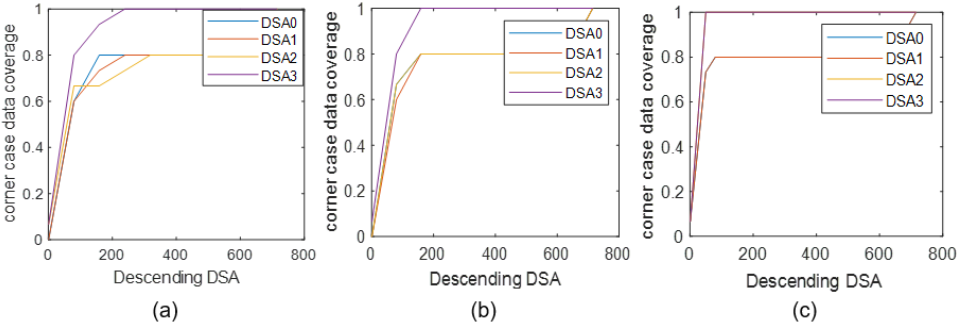
Figure 12. Corner case data coverage variance as the descending DSA. ( a ) Layer1. ( b ) Layer2. ( c ) Layer3.